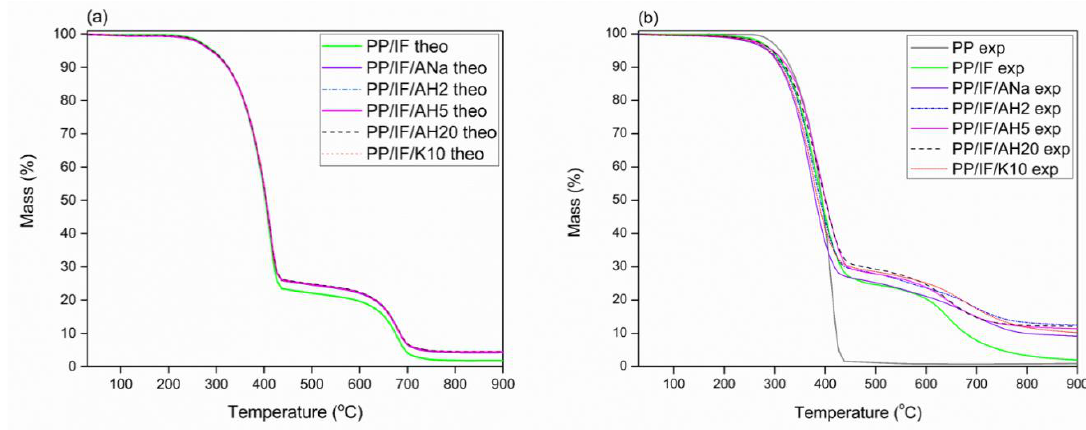
Figure 6. Thermogravimetric analysis: ( a ) theoretical TGA curves; ( b ) experimental TGA curves of neat PP, PP / IF and PP / IF / clay